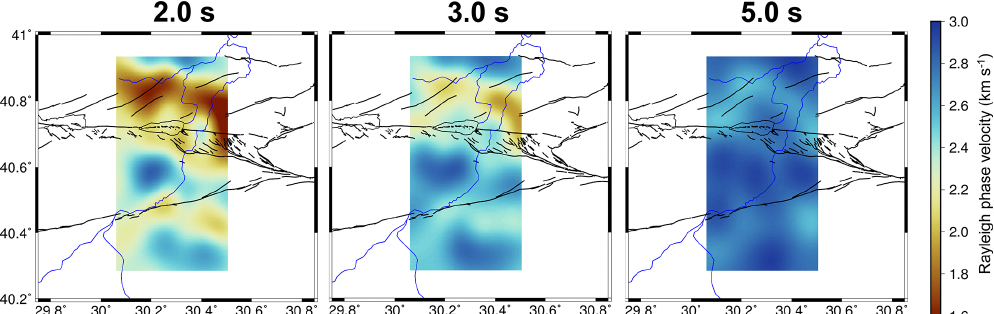
Figure 3. Rayleigh wave phase velocity maps at 2.0, 3.0 and 5.0s periods. Black lines show the mapped faults. The blue line represents the Sakarya River flowing towards the north.